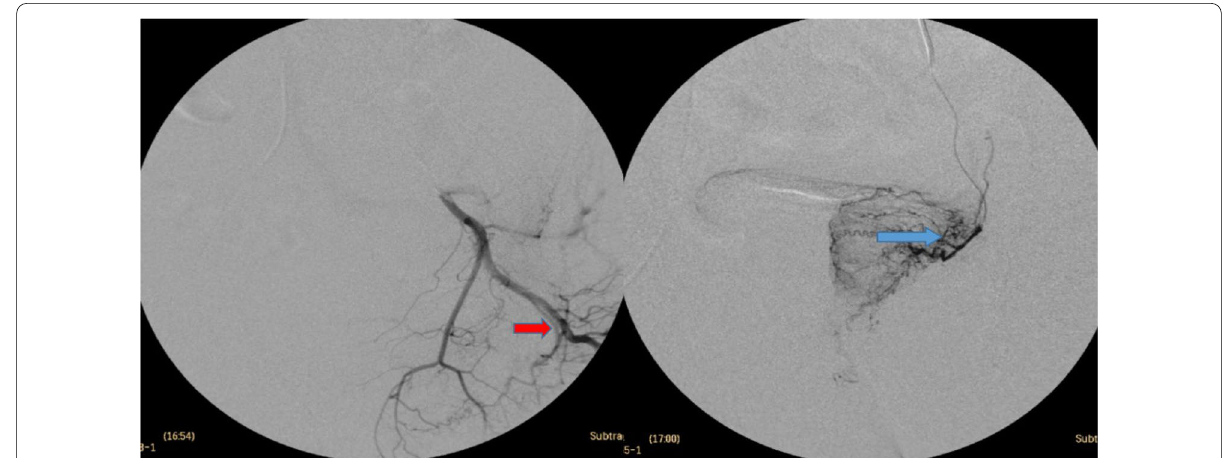
Fig. 15 Angiography images showing the origin of left prostatic artery (blue arrow) arising from pudendal artery (red